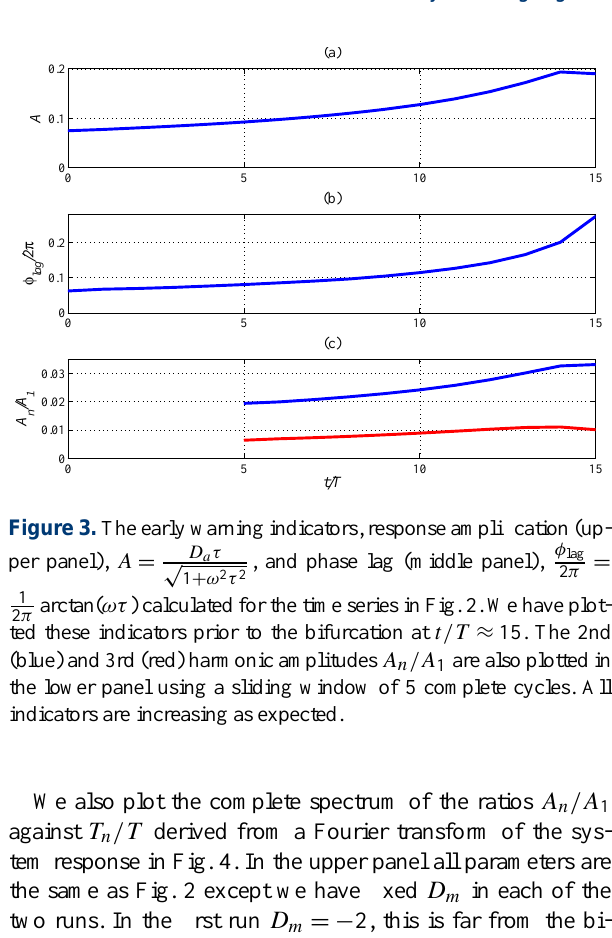
phase lag depends on ω , one must take this into account when inferring system timescales from the indicators.